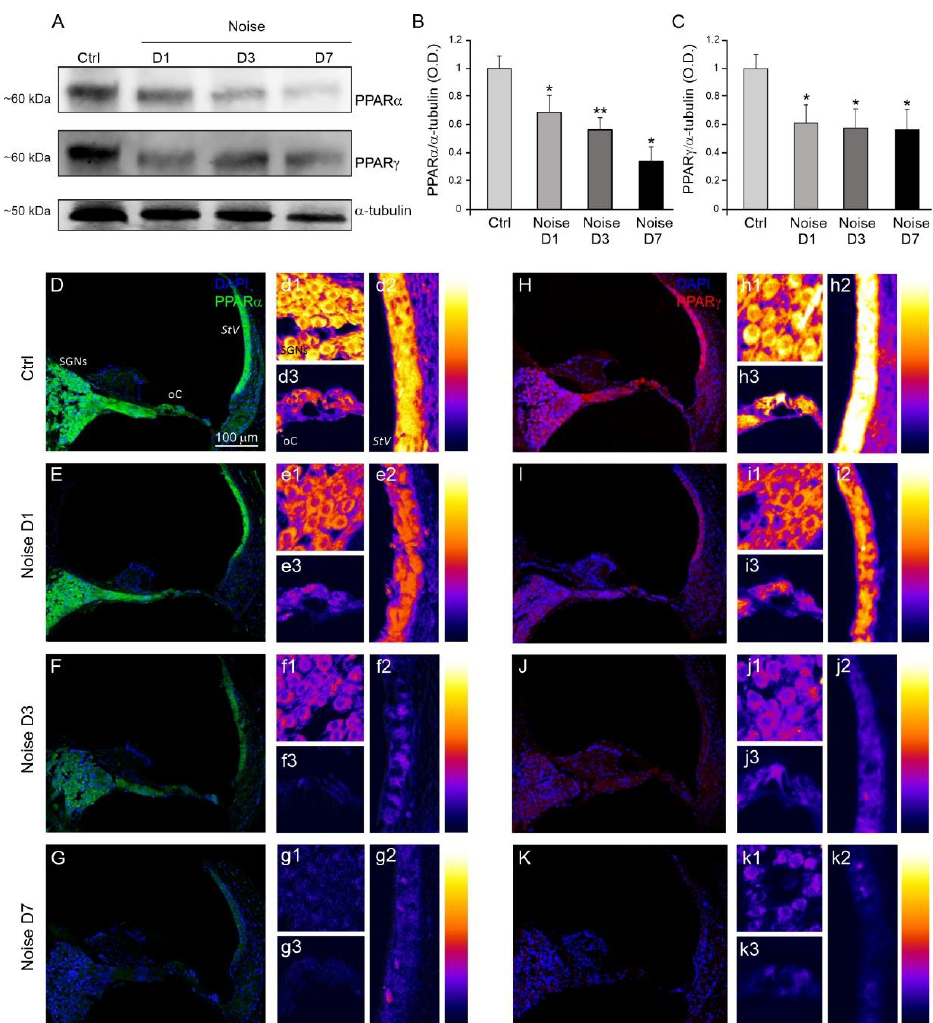
Figure 3. Noise exposure reduces PPARα and PPARγ expression in the cochlea. ( A ): Western immunoblotting showing PPARα and PPARγ reduction at 1, 3 and 7 days ( D ) after noise exposure. ( B , C ): Histograms show the decrease in PPARα/α-tubulin and PPARγ/α-tubulin ratios after noise exposure (optical density, O.D.). Data are expressed as mean ± SEM from three independent experiments. Asterisks indicate significant differences between groups (* p < 0.05; ** p < 0.01). ( D – K ): Representative images of cochlear cryosections labeled for PPAR α (green fluores- cence, ( D – G )) and PPAR γ (red fluorescence, ( H – K )) and double-stained with DAPI in blue. Inserts in ( d1 – k3 ) indicate the distribution of fluorescence signal, analyzed in a pseudo-color rainbow scale for the principal cochlear structures. PPAR α and PPAR γ fluorescence is marked in control samples and progressively decreases from day 1 to day 7 after noise exposure. StV: stria vascularis ; oC: organ of Corti; SGNs: spiral ganglion neurons. Scale bar: 100 µ